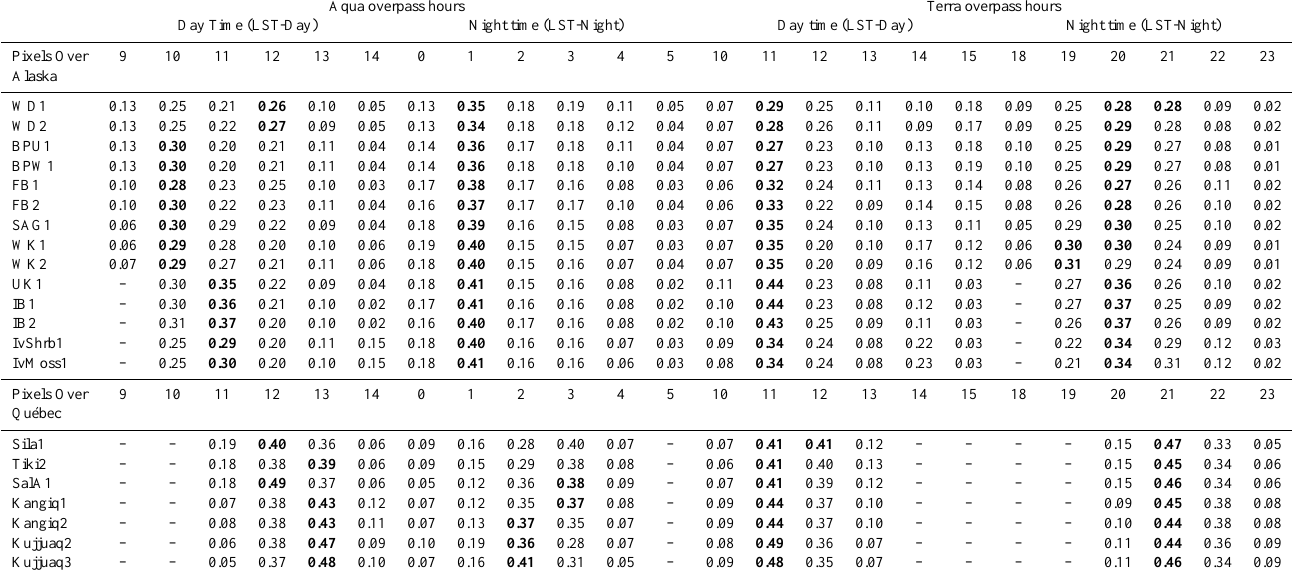
Table 3. Frequency of Aqua and Terra satellite overpasses within different hours above the field stations during the period of study (2000– 2008). The most frequent overpass times for the different stations are given in